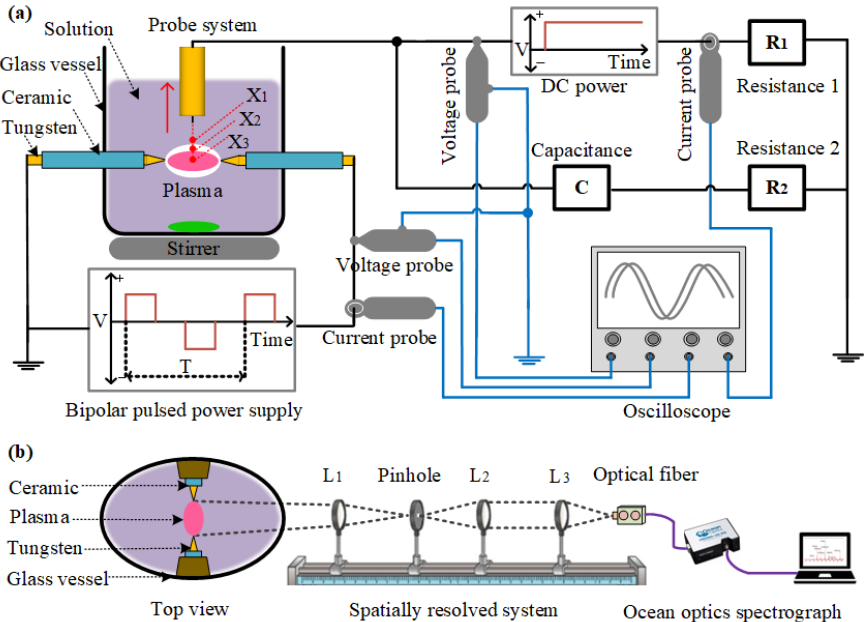
Figure 1. ( a ) Schematic illustration of the SPP experiment arrangement, Langmuir probe system, and schematic diagram of ( b ) SROES setup.